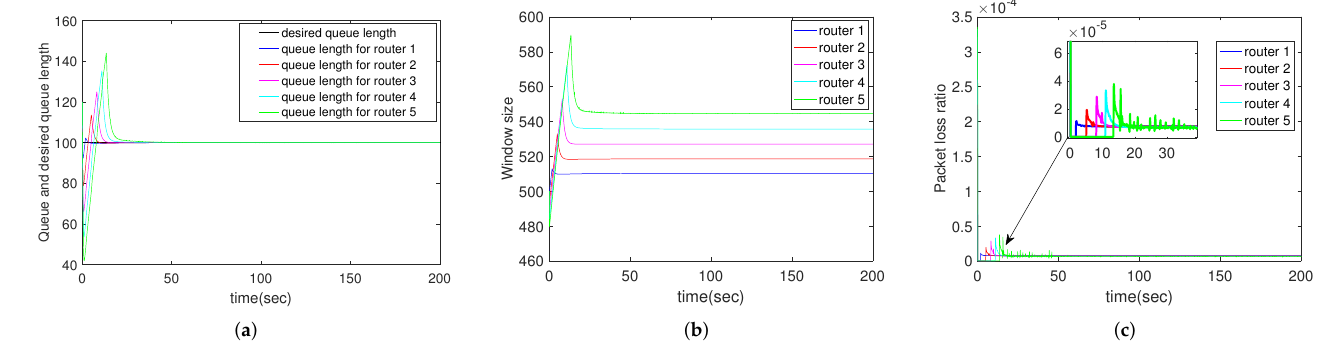
Figure 8. Simulation results of multiple routers using CCAIB for different routers. Columns from left to right show the performance of CCAIB in ( a ) queue length stability, ( b ) window size and ( c ) packet loss ratio in the